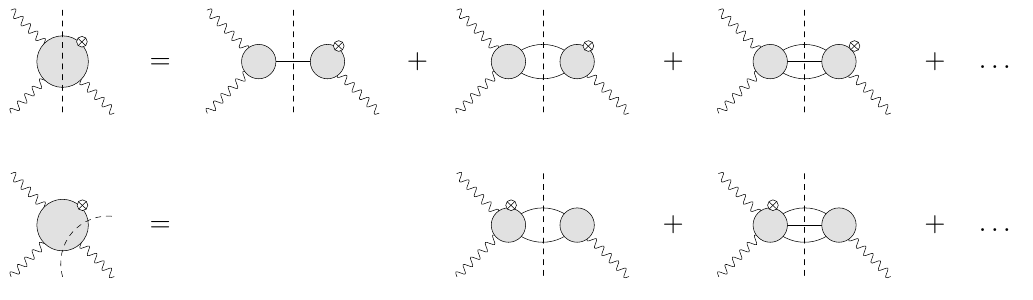
Figure 2 . The contribution of different intermediate states to the s -channel and q 2